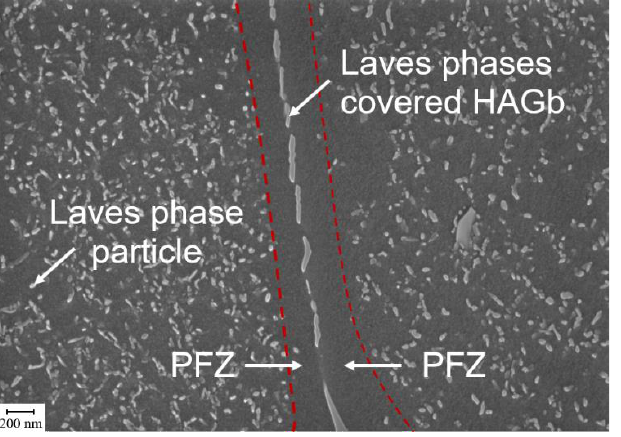
Figure 5. Microstructural features of LMD-manufactured HiperFer AM (LPD variant, further process parameters, cf. Table 2).